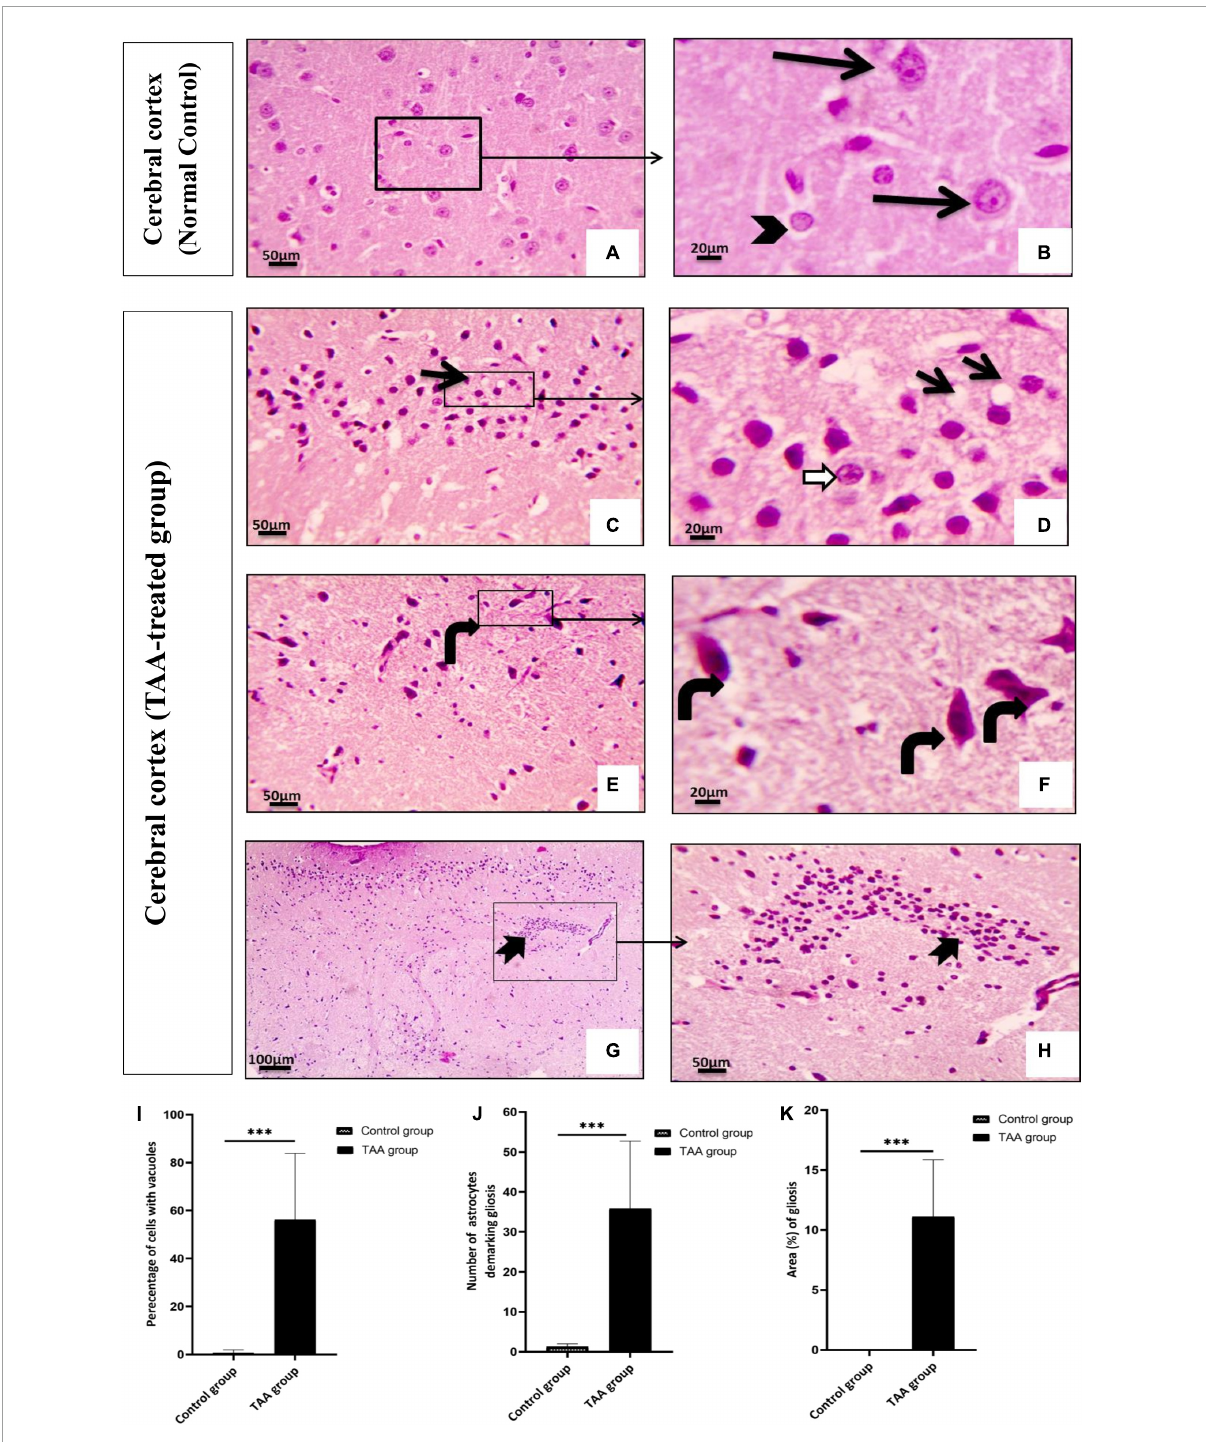
FIGURE6 (A–H) The cerebral cortex of control and treated groups stained with (H&E) . (A) Control group exhibiting the normal texture of the neuropil between the neurons. (B) Higher magnifications of the control group showing normal pyramidal neurons with their large nuclei and prominent nucleoli, basophilic cytoplasm (black arrows), normal astrocytes having larger round nuclei with pale vesicular chromatin patterns and indistinct nucleoli (arrowhead). (C–H) Cerebral cortical sections from the TAA-treated group. (C,D) Neuropil vacuolation (short arrows) and astrocytes with enlarged and relatively clear nuclei (white arrows). (E,F) Severely affected neurons with prominent eosinophilic cytoplasm and nuclear pyknosis (curved arrows). (G,H) Focal gliosis (bifid arrow). X: 400 bar 50 and X: 1000 bar 20. (I) Quantitative analysis showing the percentage of cells with vacuoles. (J) Graph showing number of astrocytes demarking gliosis and (K) showing area percentage of gliosis. Values represent mean ± SD ( ∗∗∗ p < 0.001 vs. control